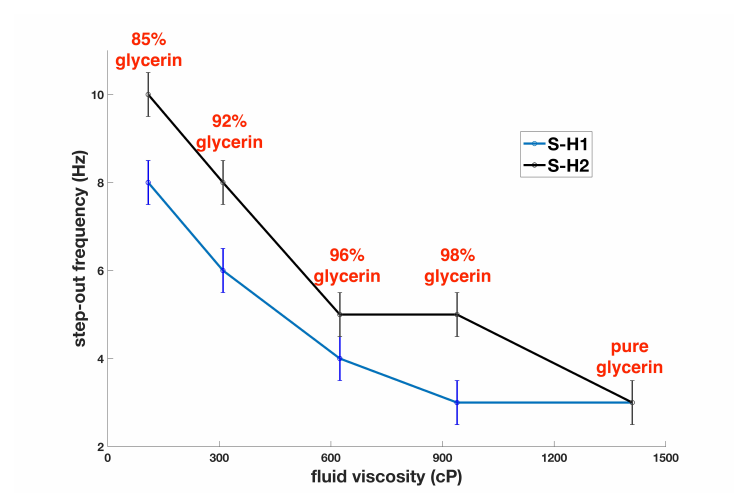
Figure 5. Step-out frequencies of S-H1 and S-H2 under increasing fluid